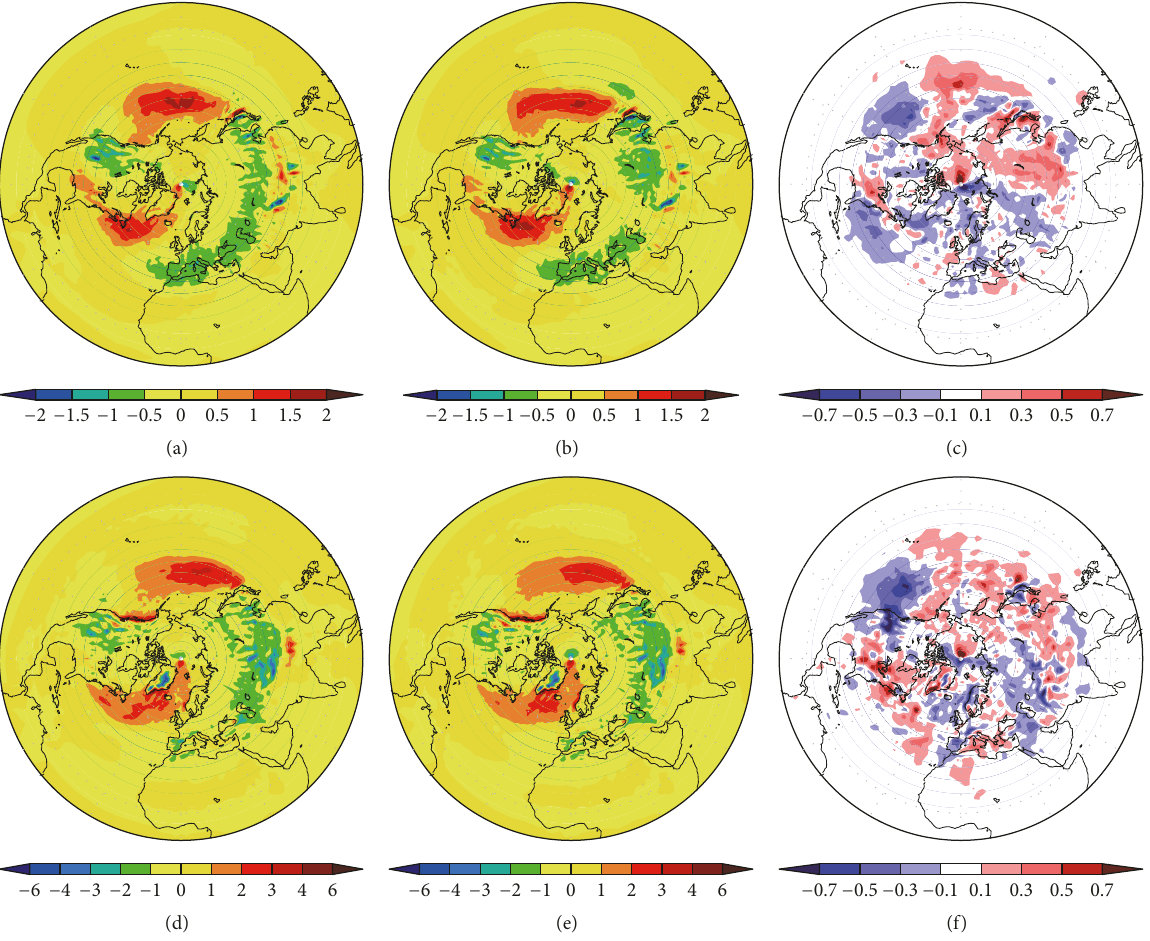
Figure 1: Wintertime (DJF) extratropical nonzonal diabatic heating (W/m 2 ) at ((a), (b), and (c)) 300 and ((d), (e), and (f)) 700 hPa derived fromERA-Interimreanalysis.Ateachrow,thefigurescorrespondtothelow((a)and(d))andhigh((b)and(e))Arcticsea-ice-coverconditions and ((c) and (f)) to their difference (low minus high)